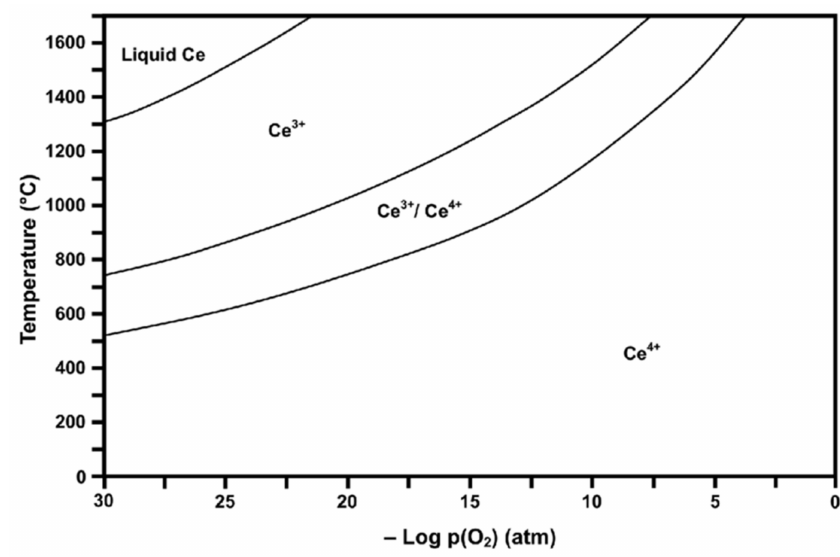
Figure 6. Ce-O stability phase diagram in different partial pressures of O 2 [127].